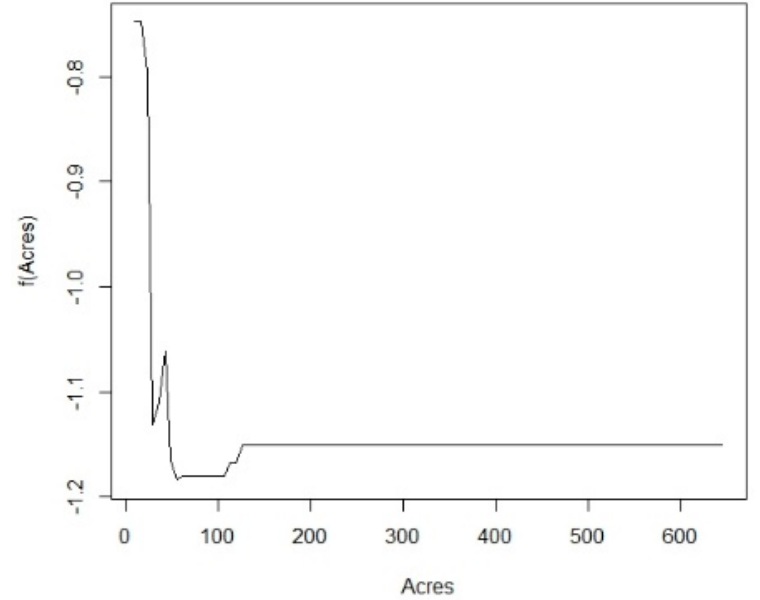
Figure 6. Partial dependence plot for acres variable for the willingness to rent model.